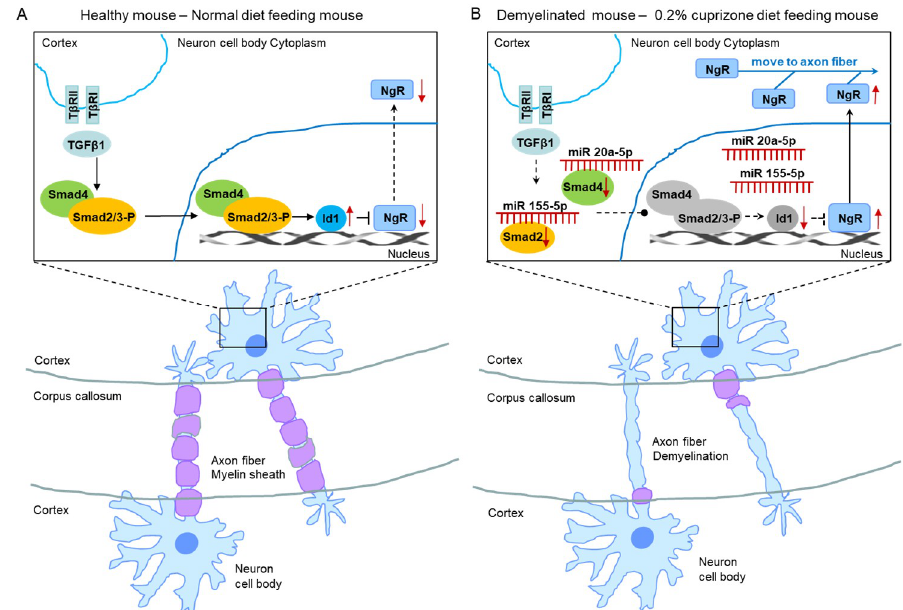
Figure 9. The proposed mechanism of miR 155-5p and miR 20a-5p upregulations led to demyelination. ( A ) The illustration shows a proposed mechanism in normal diet-fed, healthy mice. ( B ) The illustration shows that the proposed mechanism of miR 155-5p and miR 20a-5p upregulations led to demyelination in 0.2% cuprizone diet-fed mice.